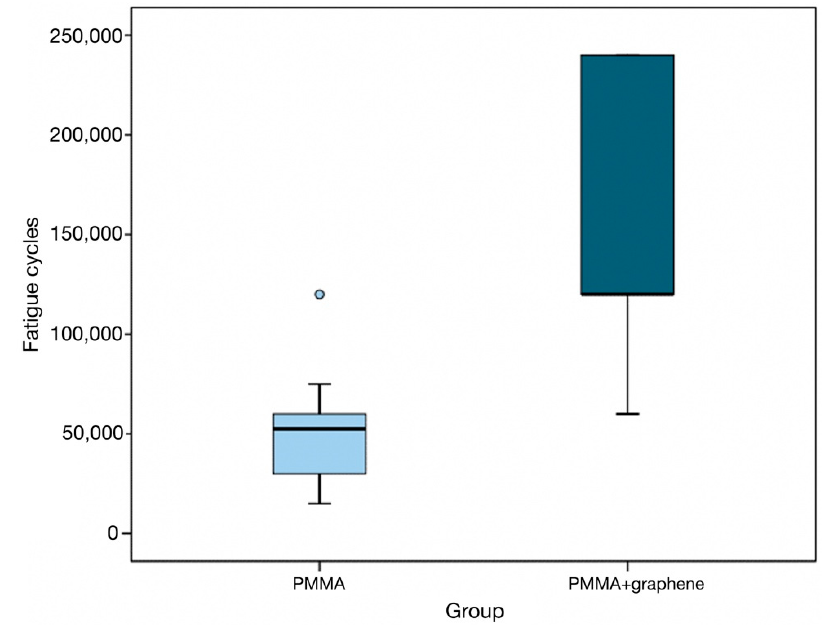
Figure 2. Maximum number of loading cycles according to group.